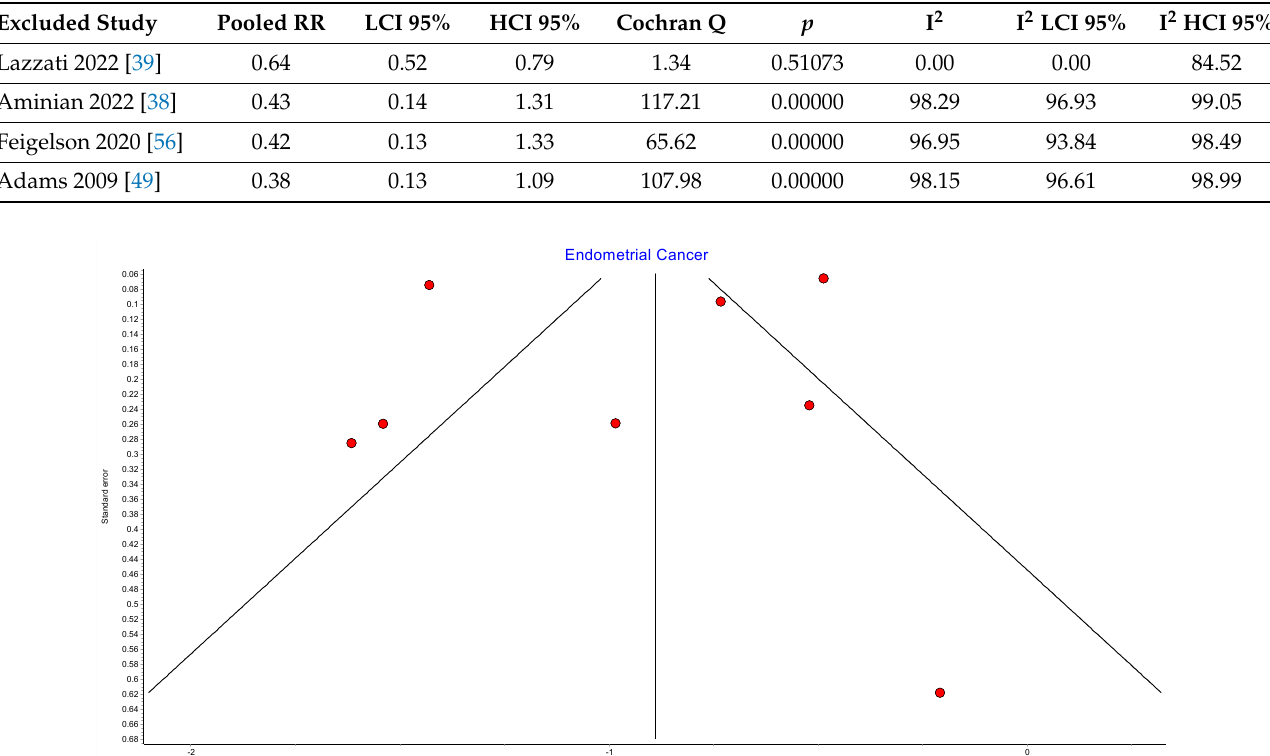
Table A7. Endometrial cancer random e ff ects model sensitivity analysis.